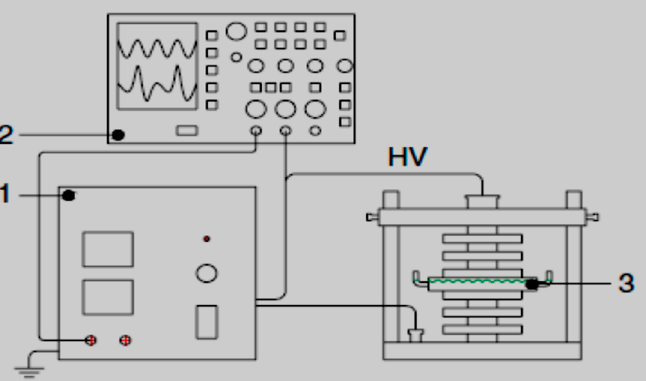
Figure 3. Experimental setup of the dielectric barrier discharge (DBD) water treatment process: 1. High voltage (HV) generator, 2. Oscilloscope, 3. Quartz reactor [156].